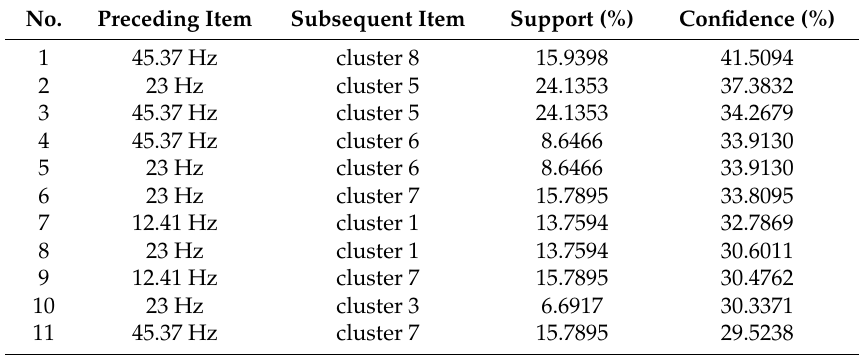
Table 12. Association rules of 1500 data segments (the adjacent data segments